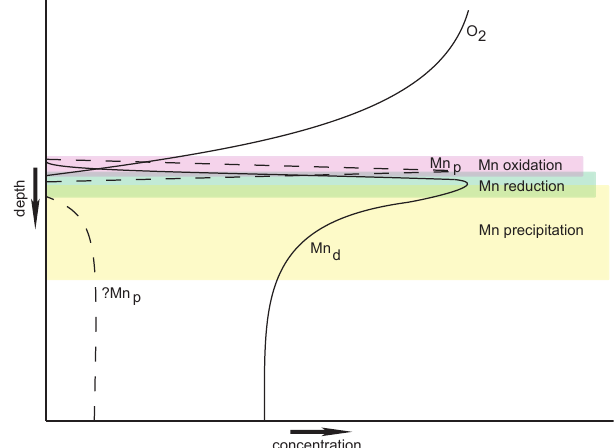
Fig. 1. Conceptualized Mn (dissolved and particulate) and O 2 pro-